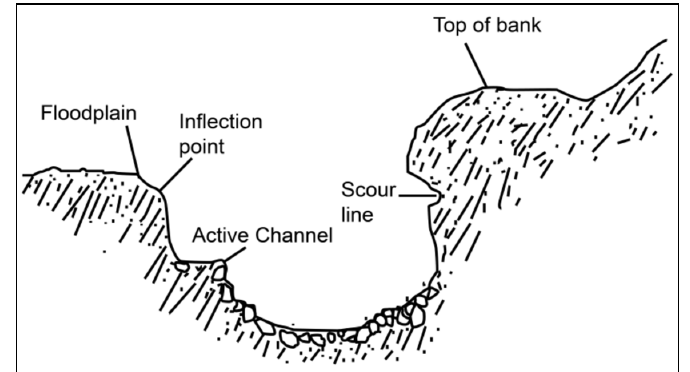
Figure 4. Cross-sectional diagram of bankfull indicators. Table 1. Estimated bankfull discharge at the Byeongseong river (bankfull mean depth (D bf ; m); bankfull width (W bf ; m); bankfull discharge (Q bf ; m 3 /s); bankfull indicator (B.I.)). Distance